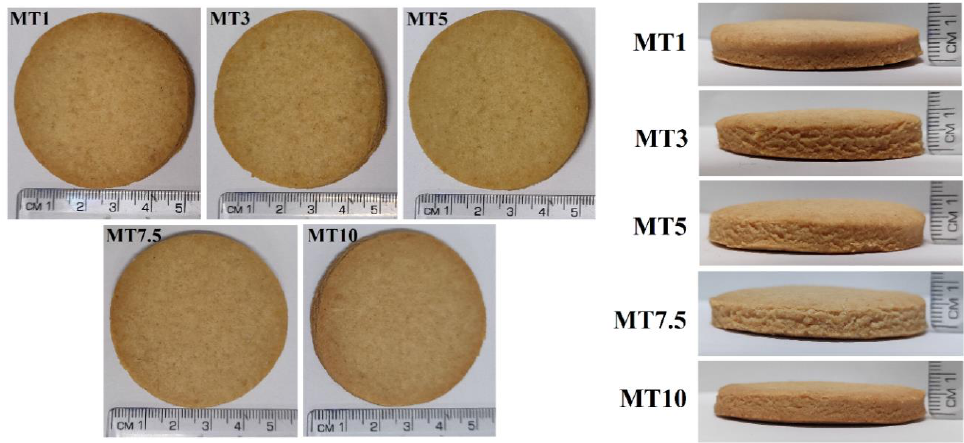
Figure 12. Visual appearance of the cookies .